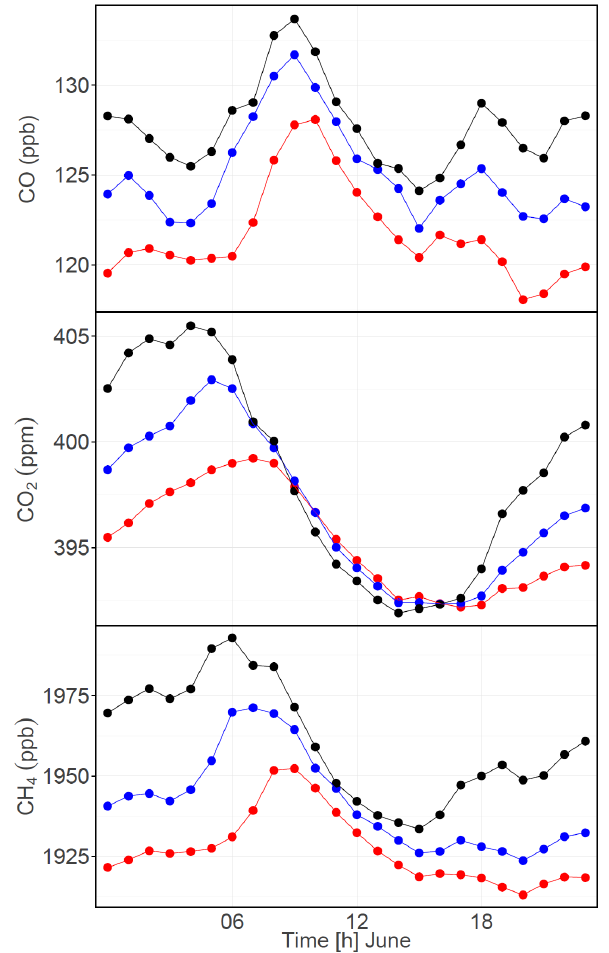
Figure 9. Mean diurnal cycles of CO, CO 2 , and CH 4 mixing ra- tios measured at 12.5m (black), 71.5m (blue), and 212.5m (red) on the tower in June 2013. Time is local time (GMT + 01:00), and the lowest and highest 5% of the data in each hour was excluded before